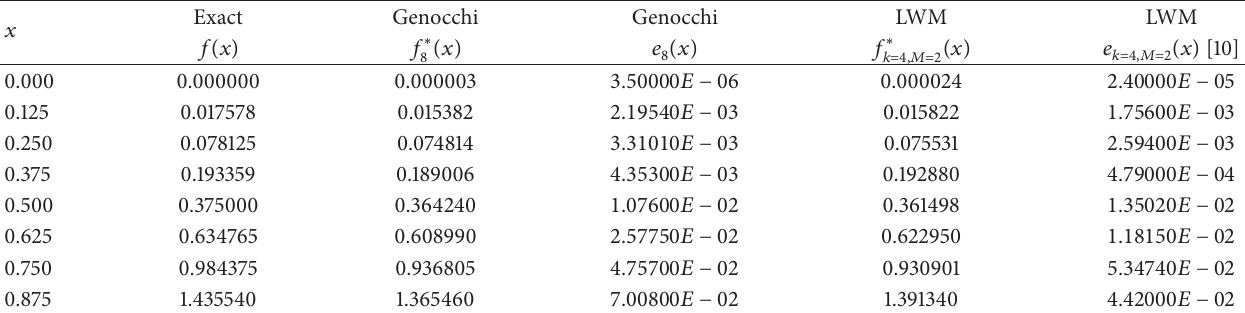
Table 6: Comparison of approximate solutions for Example 4 using 𝑁 = 8 order Genocchi polynomials and Legendre wavelet method (LWM) [10] for 𝑘 = 4 and 𝑀 = 2 .